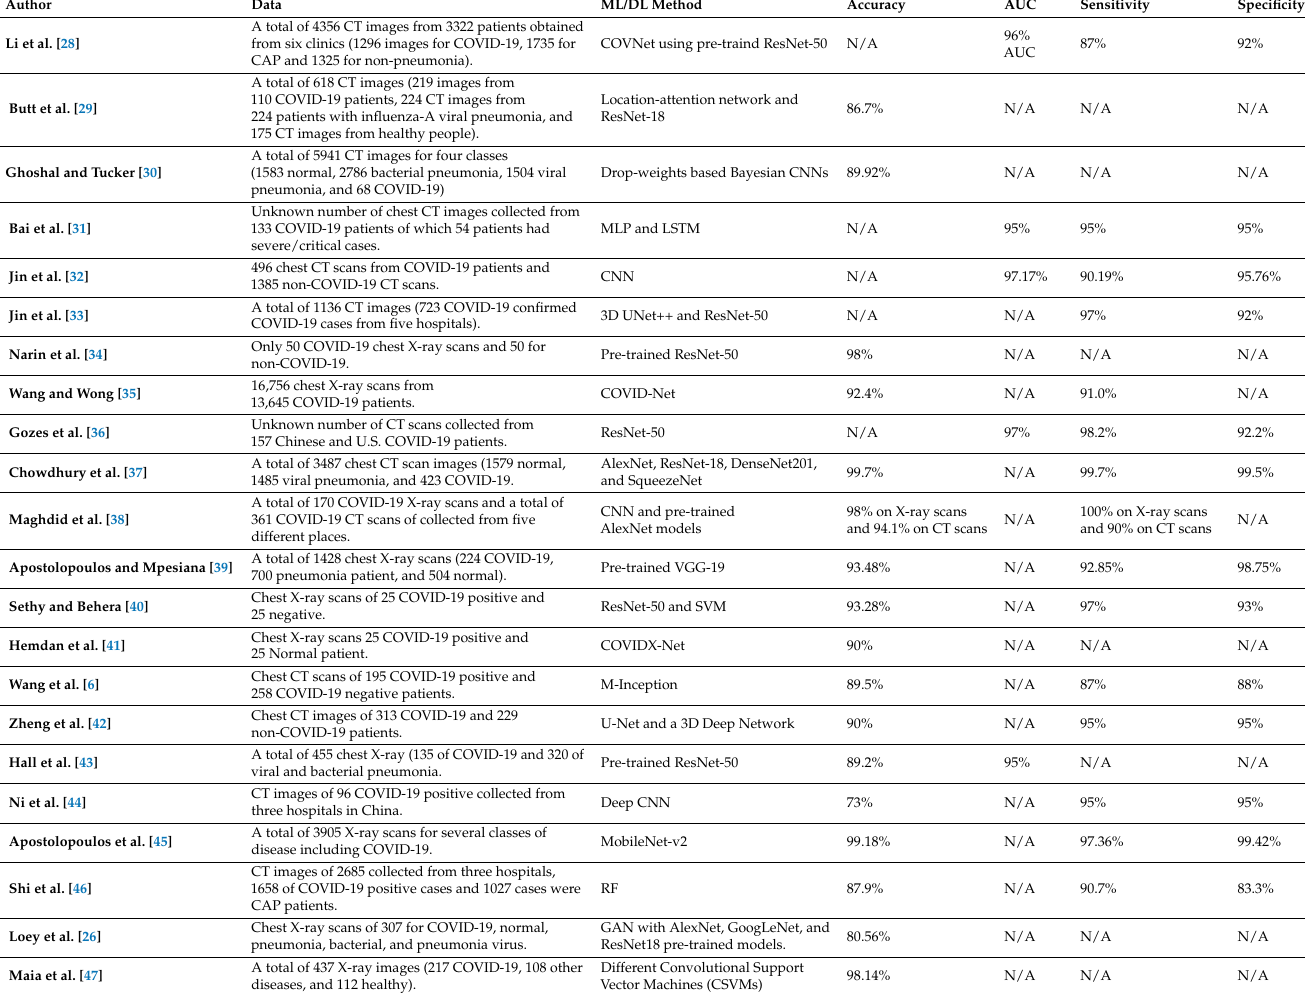
Table 1. A summary of predictive performance of Artificial Intelligence (AI)-based ML and DL techniques for diagnosing COVID-19 using chest X-ray and CT